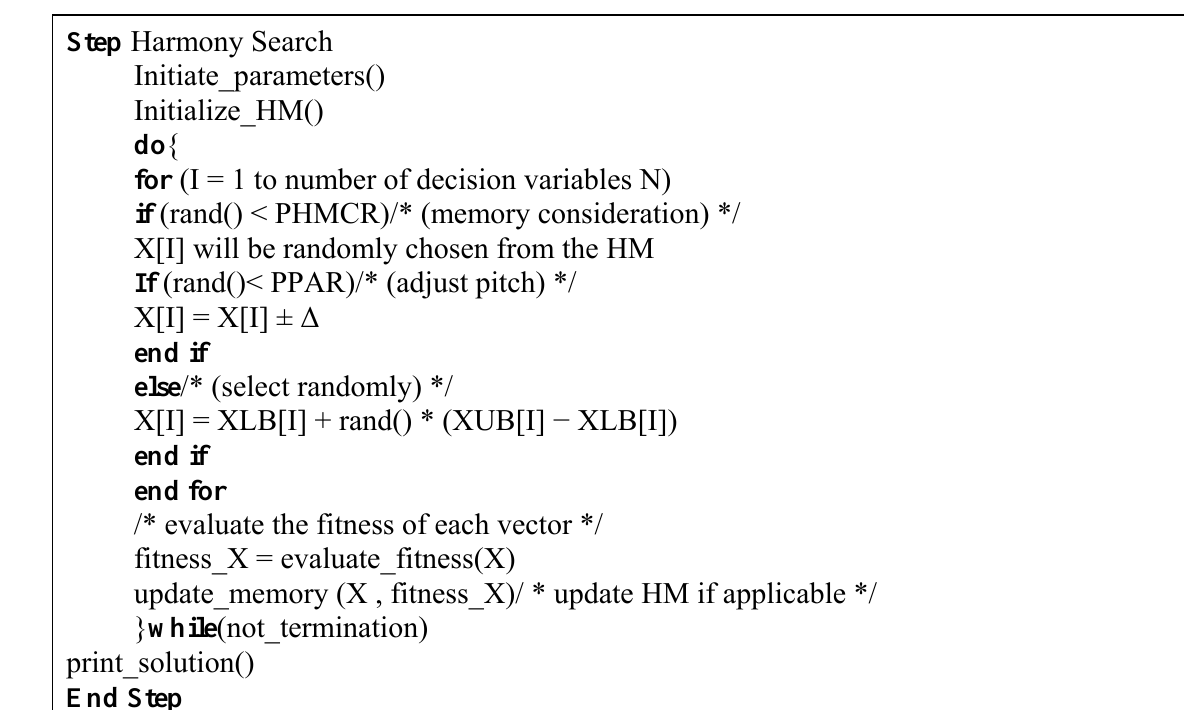
Table 3. Pseudo-code of the harmony search (HS)